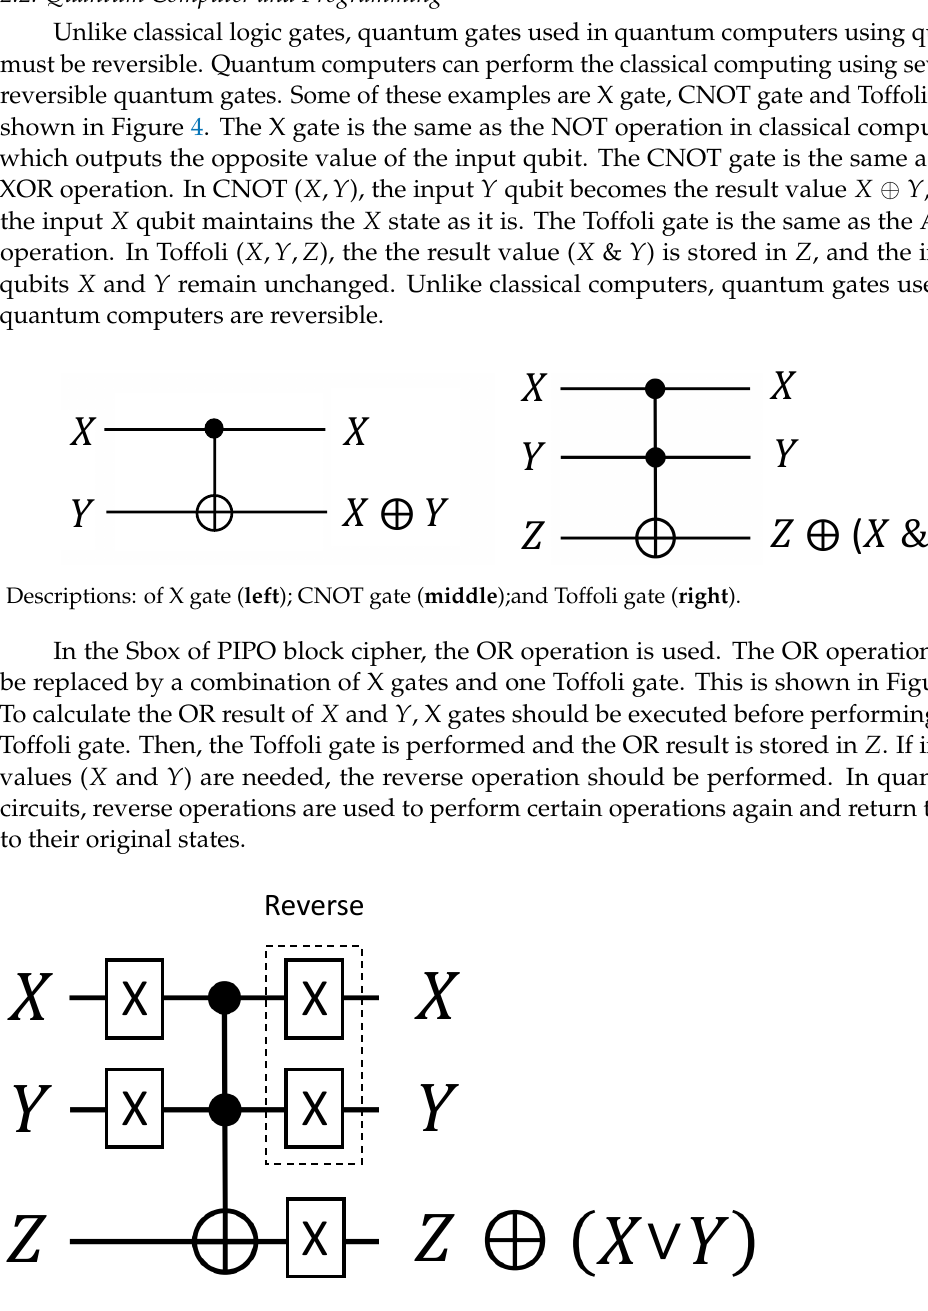
Figure 5. OR operation in quantum